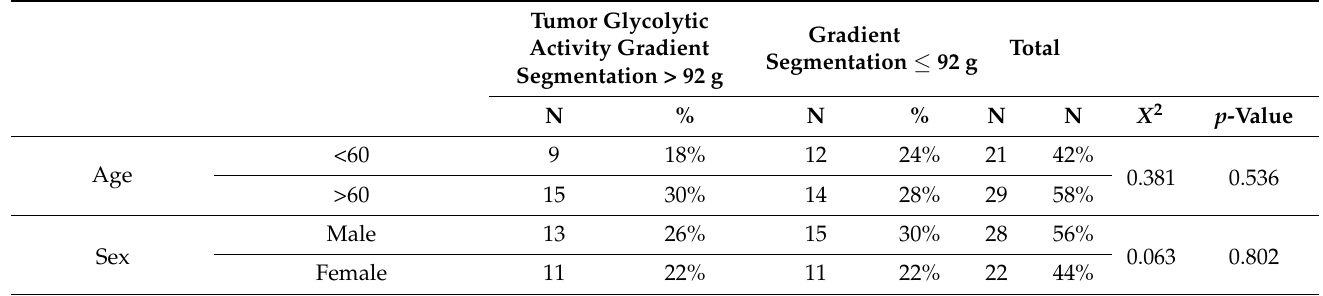
Table 2. The relation of tumor glycolytic activity to the treatment modality as well as to patient and tumor characteristics and